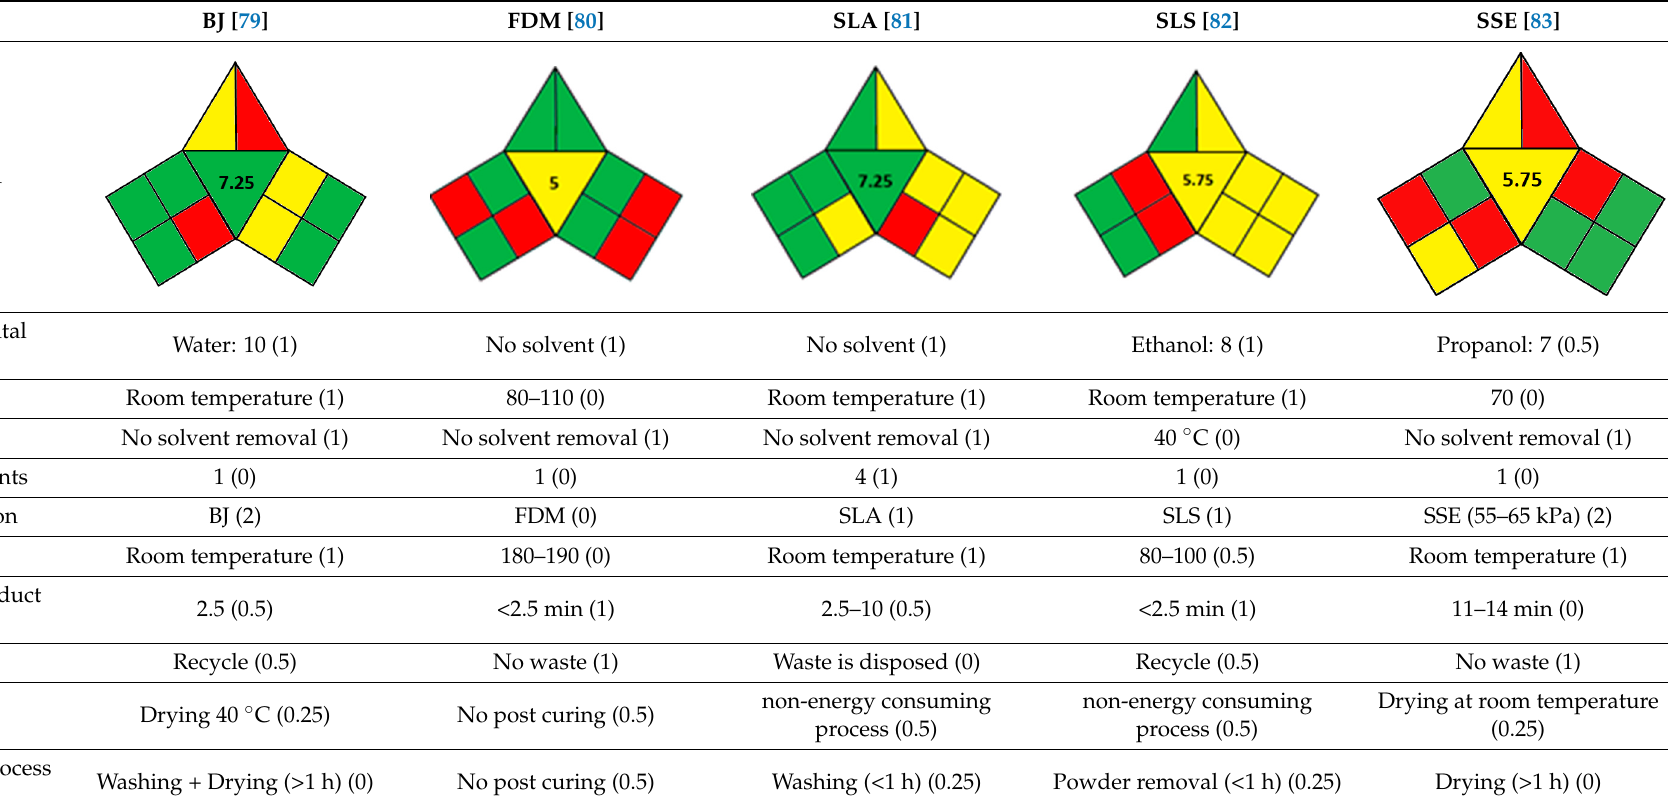
Table 3. Greenness profile of 3DP tablets by reported BJ, FDM, SLA, SLS, and SSE methods.